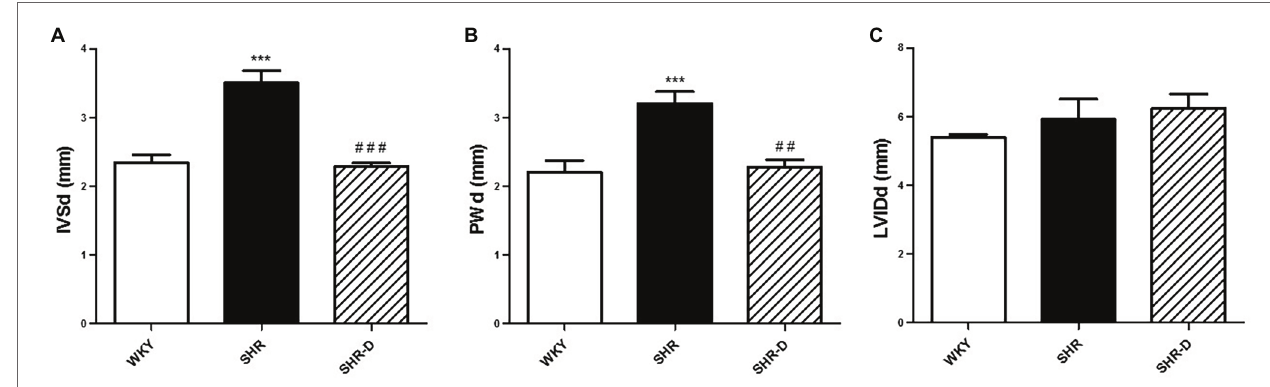
FIGURE 1 | Echocardiographic parameters with M-mode measurements. (A) Interventricular septal end-diastolic thickness (IVSd), (B) posterior wall diastolic thickness (PWd), and (C) left ventricular internal diastolic diameter (LVIDd) measurements from Wistar-Kyoto rats (WKY) treated with vehicle, spontaneously hypertensive rats (SHRs) treated with vehicle, and spontaneously hypertensive rats treated with dronedarone (SHR-D). Statistically significant differences among WKY, SHR, and SHR-D are shown ( *** p < 0.001 vs. WKY; ## p < 0.01 vs. SHR; and ### p < 0.001 vs. SHR). Values are shown as mean ± SEM ( n = 8 per group).